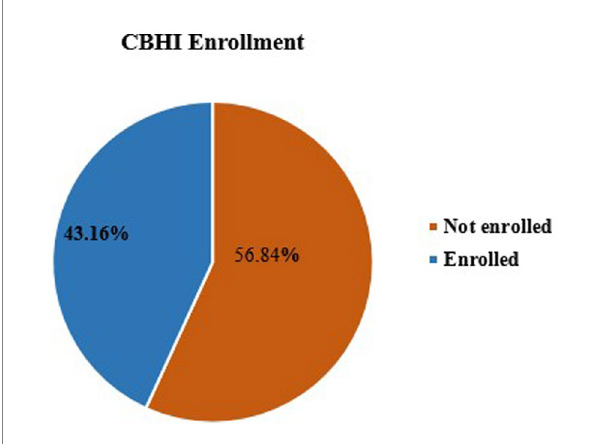
FIGURE 1 Prevalence of enrolment in community-based health insurance among reproductive-age women,